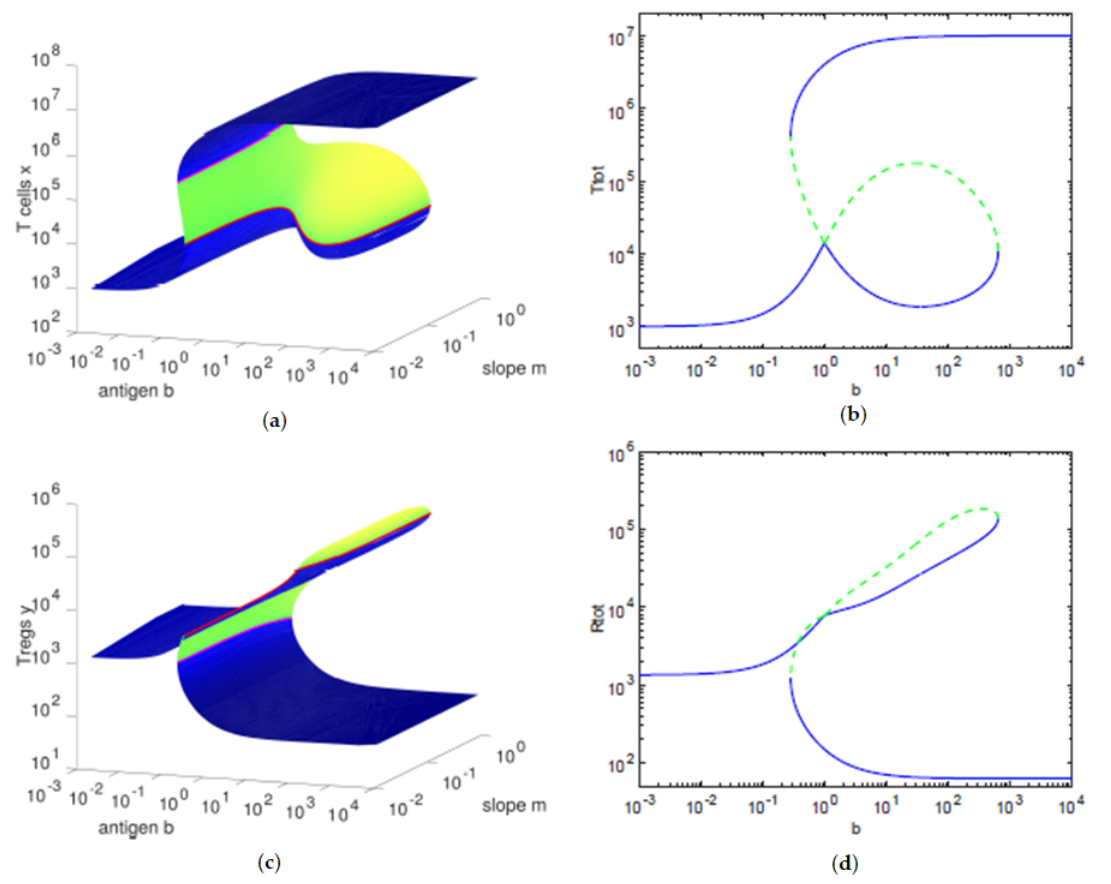
Figure 2. Equilibria manifold obtained from Theorem 1. ( a , b ) relationship between the antigenic stimulation b of T cells and the concentration of T cells x = T + T ∗ . ( c , d ) relationship between the antigenic stimulation b of T cells and the concentration of Tregs y = R + R ∗ . ( a , c ) the axis pointing upwards to the right is the slope parameter m . The shading color indicates the real part of the largest eigenvalue Re ( λ ) , increasing from black to blue for stable equilibria, and unstable equilibria from green to yellow. The red and the magenta lines show the bifurcations, when Re ( λ ) = 0. ( b , d ) cross-sections for m = 0.2765. The line type indicates stable (solid) or unstalbe (dashes)